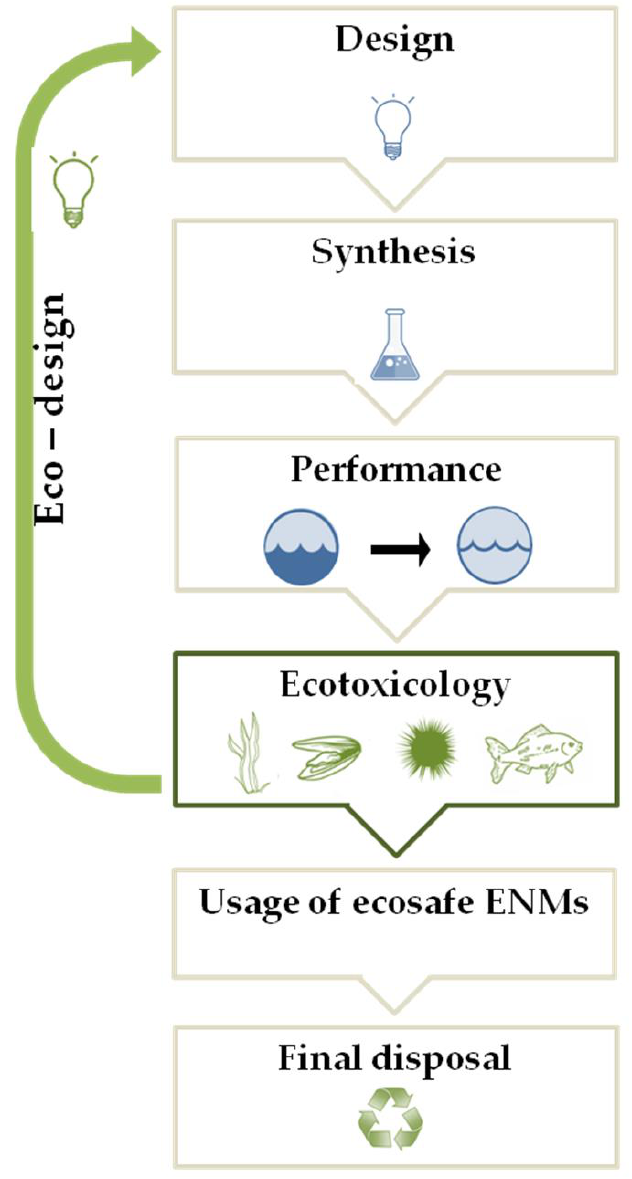
Figure 1. A schematic representation of the eco-design approach (see text for details).